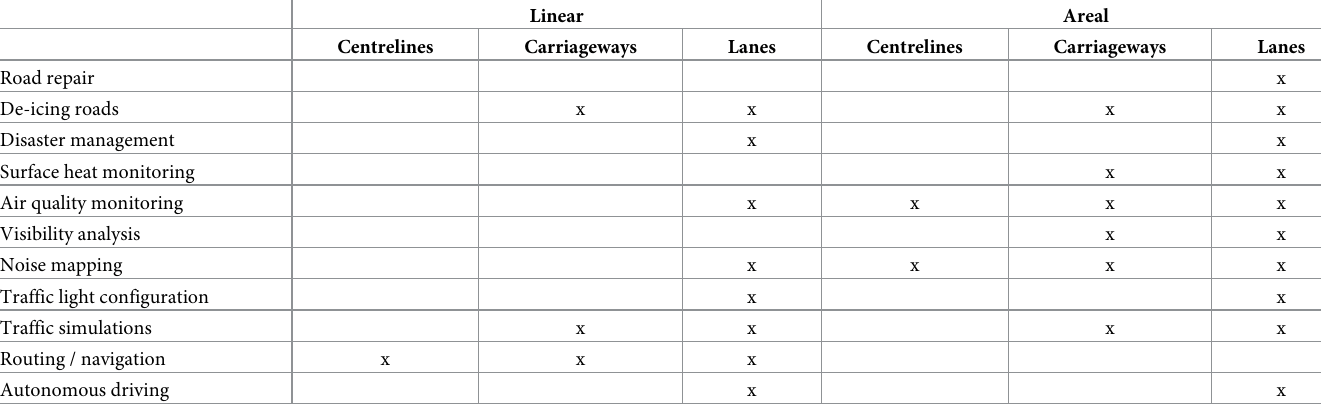
Table 1. Road data representation level required by potential applications. Table based on the work of